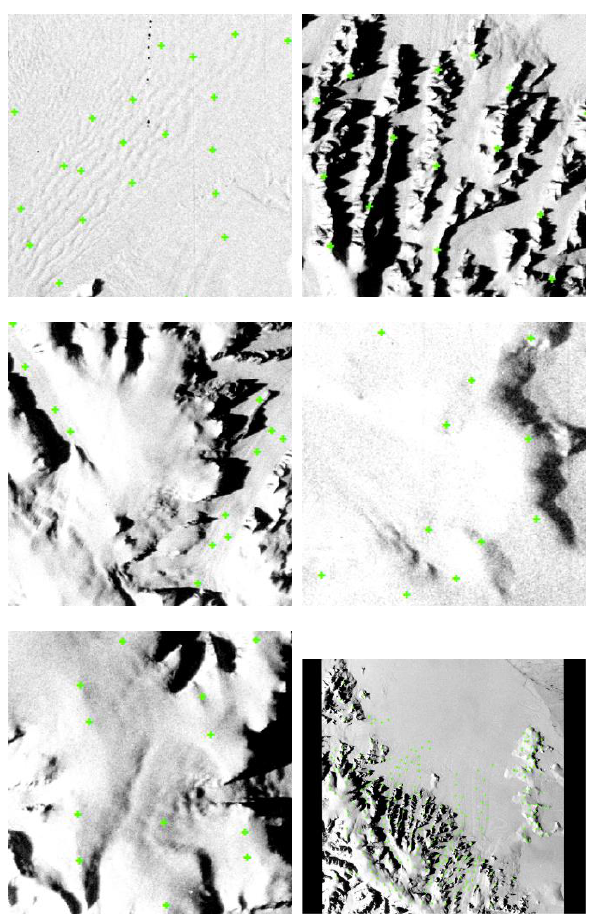
Figure. 4. Distribution of check points over five test regions and entire region Matched points are evaluated at each level were by selecting manual points. Here automatically matched points compared with the manually check points (CPs) in the image space to calculate the point distances represent matching residuals (Li et al. 2011). Grid was drawn according to the image scale at each Table 2. The external accuracy of Larsen B BA estimated by level and no more than one point in one cell when select CPs. check points